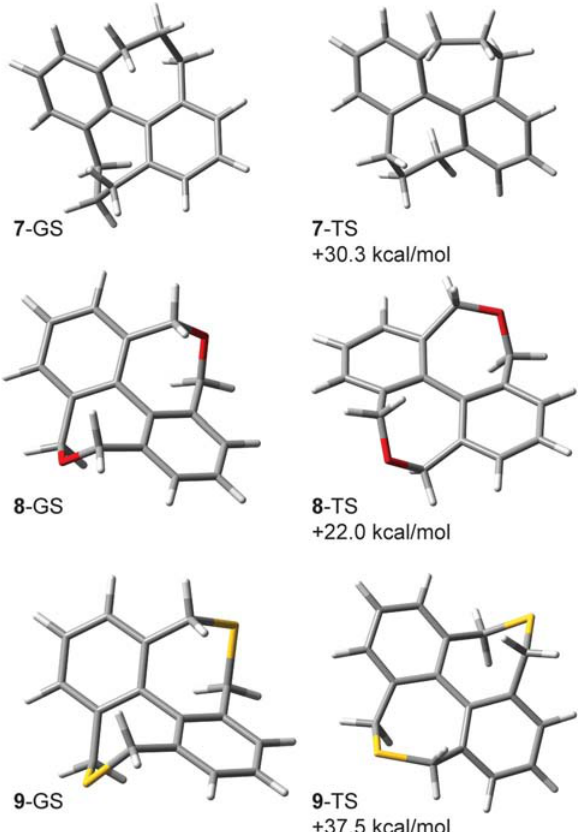
Figure 6. B3LYP/6-31G(d,p) lowest-energy ground state (GS) structures and transition structures (TS) and their computed enthalpies of activation (  H ‡ ) for compounds 7 – 9